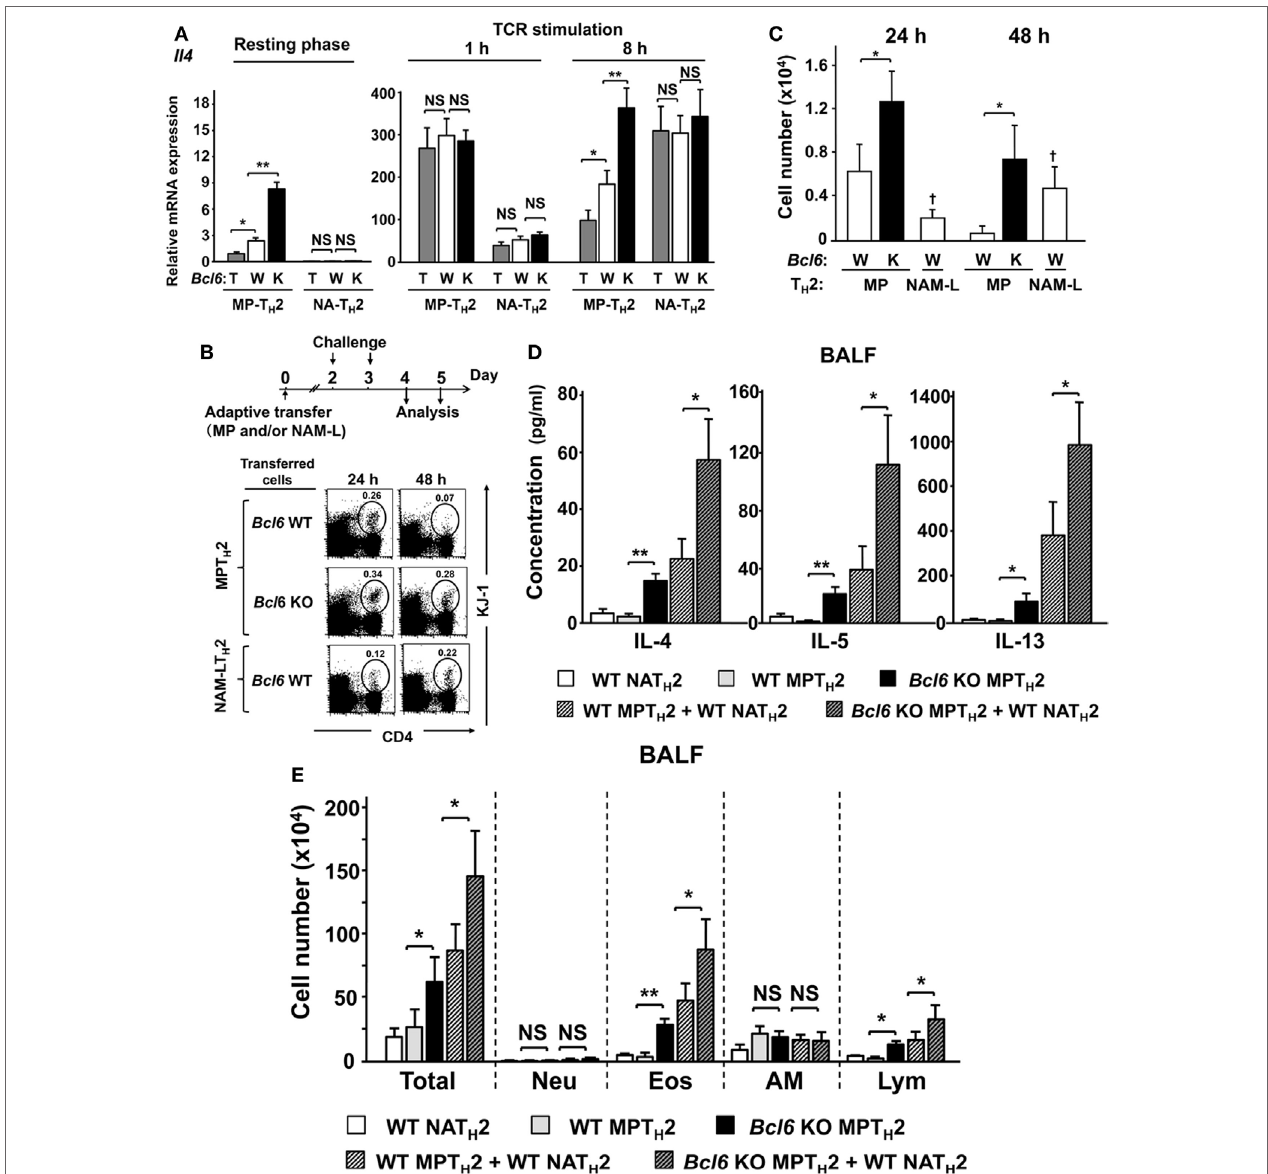
FigUre 8 | Role of Bcl6 in interactions between MPT H 2 and naïve NAT H 2 cells in allergy pathogenesis. (a–e) KJ1-26 + MPT H 2 cells and NAT H 2 cells were differentiated from the spleens of Bcl6 -TG (T), Bcl6 -WT (W), and Bcl6 -KO (K) mice in the presence of OVA peptides and antigen-presenting cells in T H 2 conditions. (a) Il4 mRNA levels in each T H 2 cell type were measured by qRT-PCR at rest and at 1 and 8 h after restimulation with anti-CD3 monoclonal antibodies. (B–e) Bcl6 -WT BALB/c nu/nu mice were administered KJ1-26 + MPT H 2 cells (3 × 10 7 ), KJ1-26 + NAT H 2 cells (3 × 10 7 ), or combinations of MPT H 2 (1.5 × 10 7 ) and NAT H 2 cells (1.5 × 10 7 ) via adoptive transfer (day 0). (B) Representative FACS data for donor cells in circles with their percentages among total CD4 + T cells in whole lungs from recipients at 24 and 48 h after the last intratracheal OVA challenge. (c) Absolute numbers of KJ1-26 + cells in the lungs, (D) T H 2 cytokine levels, and (e) cell types in the bronchoalveolar lavage fluid 48 h after the last challenge. All results are representative of four independent experiments with similar outcomes. Data are presented as the mean ± SEM ( n = 8–10) . * P < 0.05, ** P < 0.01, comparison between two groups is indicated (a,B,D,e) ; † P < 0.05, compared with MPT H 2 cells. AM, alveolar macrophages; Bcl6, B-cell lymphoma 6; Eos, eosinophils; FACS, fluorescence-activated cell sorting; KO, knockout; Lym, lymphocytes; MPT cell, memory phenotype CD4 + T cell; MPT H 2 cell, MPT cell-derived T H 2 cell; NAT H 2 cell; naïve CD4 + T cell-derived T H 2 cell; Neu, neutrophils; NS, not significant; OVA, ovalbumin; TCR, T cell receptor; TG, transgenic; WT,